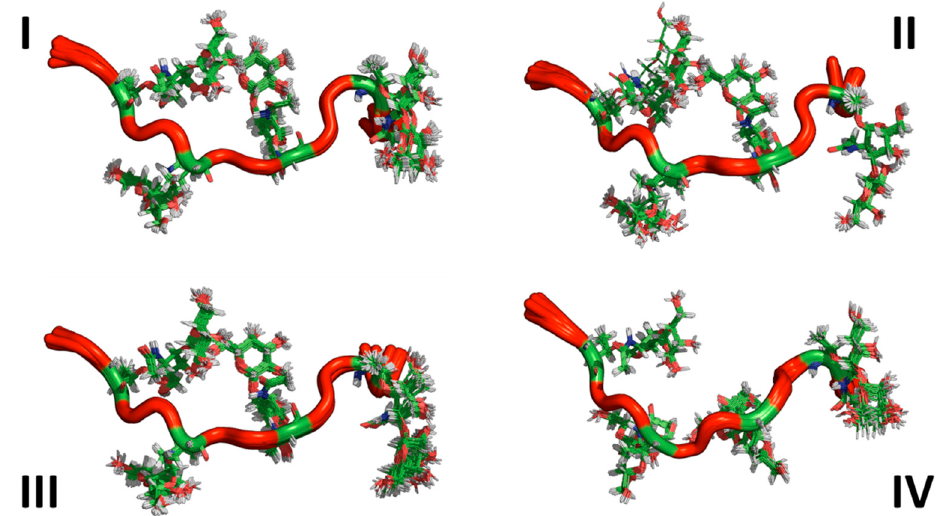
Figure 3. Clusters of substates in the representative ensemble NMR structures of AFGP8-BS. The top 4 clusters of the representative NMR structures of the total 128 structures. The structures are represented as cartoons, with the glycosylated threonine residue shown in lines. The number of structures in each cluster is Cluster I = 25, Cluster II = 22, Cluster III = 22, and Cluster IV = 11.